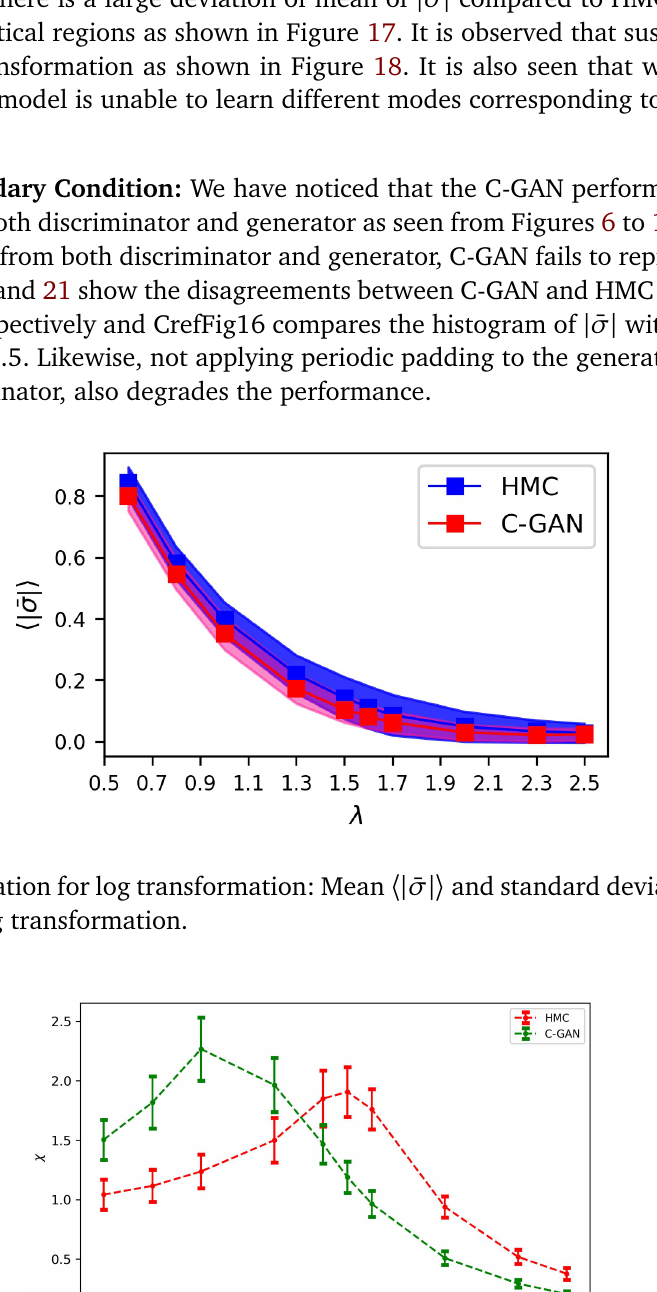
Figure 18: Ablation for log transformation: Susceptibility on Λ